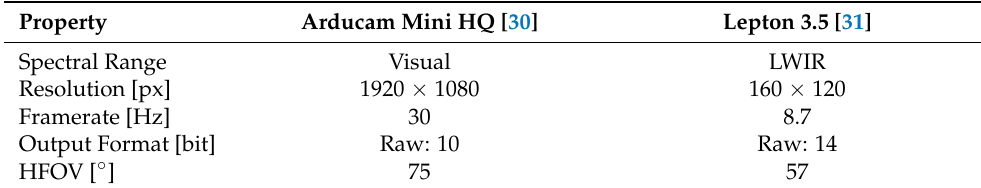
Table 3. Camera properties and parameters used in this work.